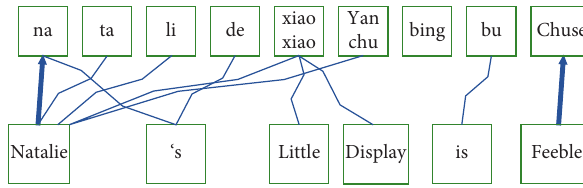
Figure 5: Example of incorrect alignment of correct sentence pairs.